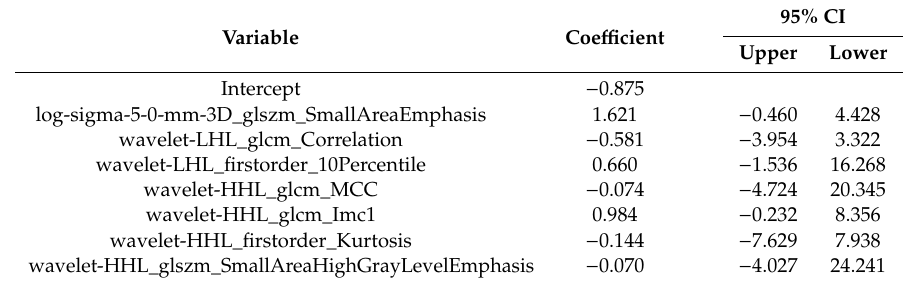
Table 2. List of selected radiomics features and their coefficients for calculation of the radiomics score.